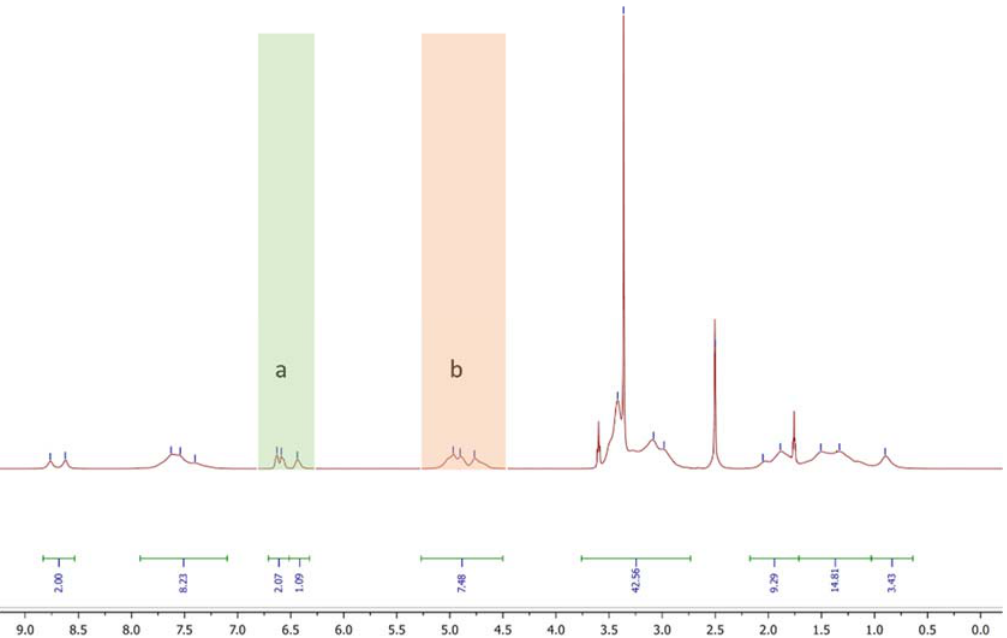
Figure 3. 1 H-NMR (DMSO-d 6 , 500 MHz, 298 K) of P(HEAA/DMA 10 ), ( a ) peaks of aromatic DMA protons, ( b ) peaks of OH HEAA protons. Table 1. Experimental data of the synthesized acrylamide copolymers.